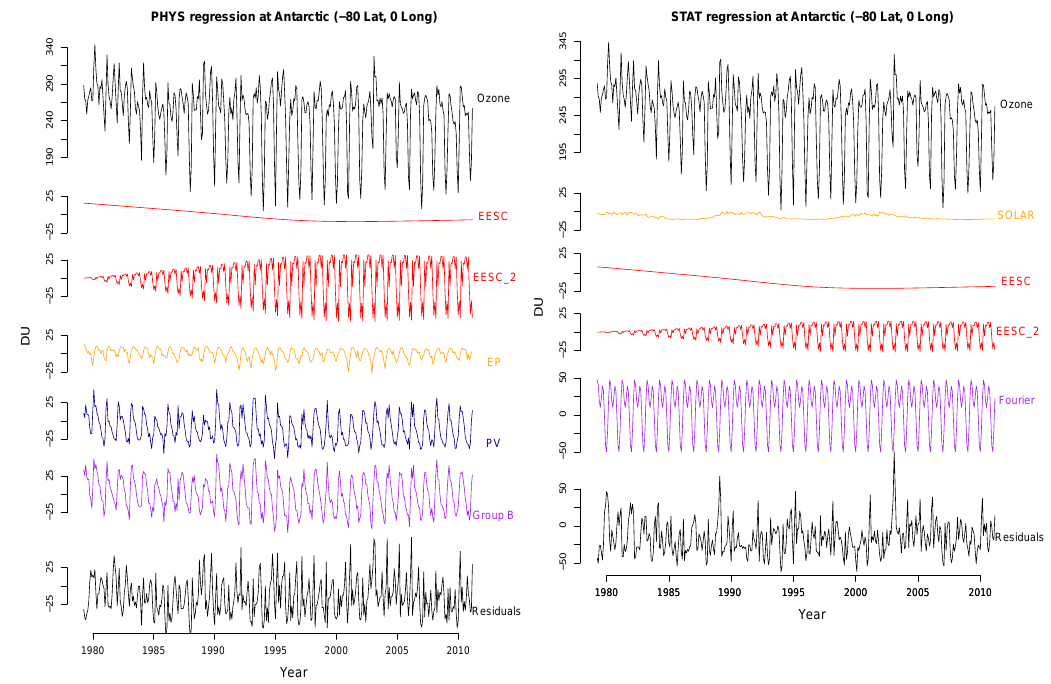
Figure 9. Results of the PHYS regression (left plot) and of the STAT regression (right plot) at 70 ◦ S, 0 ◦ E (Antarctica). “Fourier” is defined as the sum of the harmonic components that describe seasonal variation in ozone and the “group B” term is defined as the sum of EP and PV, describing the seasonal component according to the PHYS model.